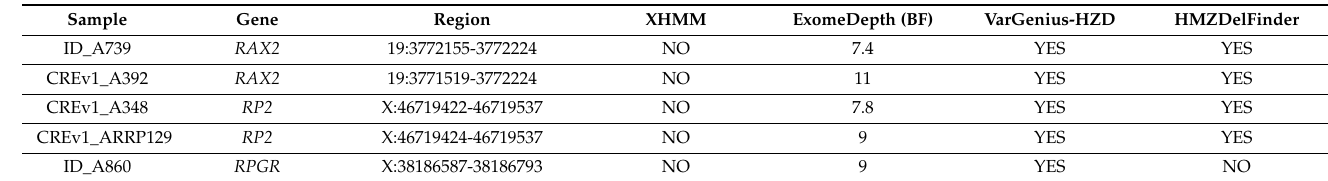
Table 4. VRCIRD cases resolved by detection of a HD.